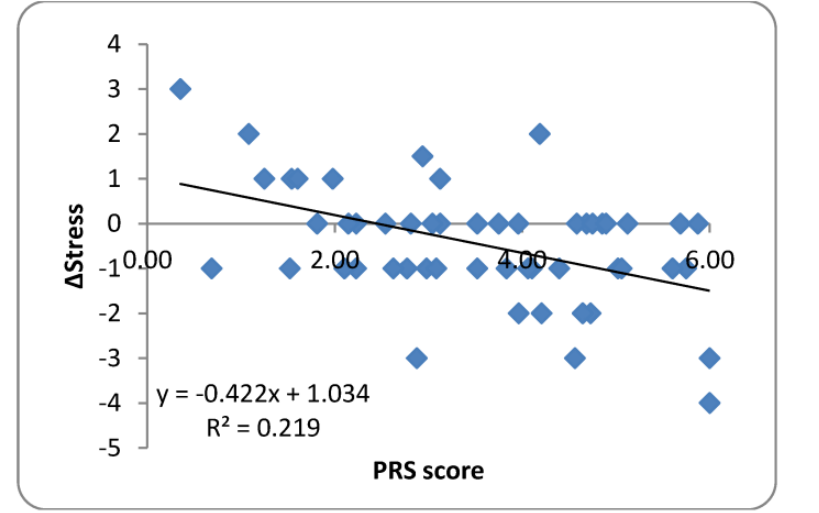
Figure 6. Simple linear regression between Perceived Restorativeness (PRS) score and change in Subjective Stress